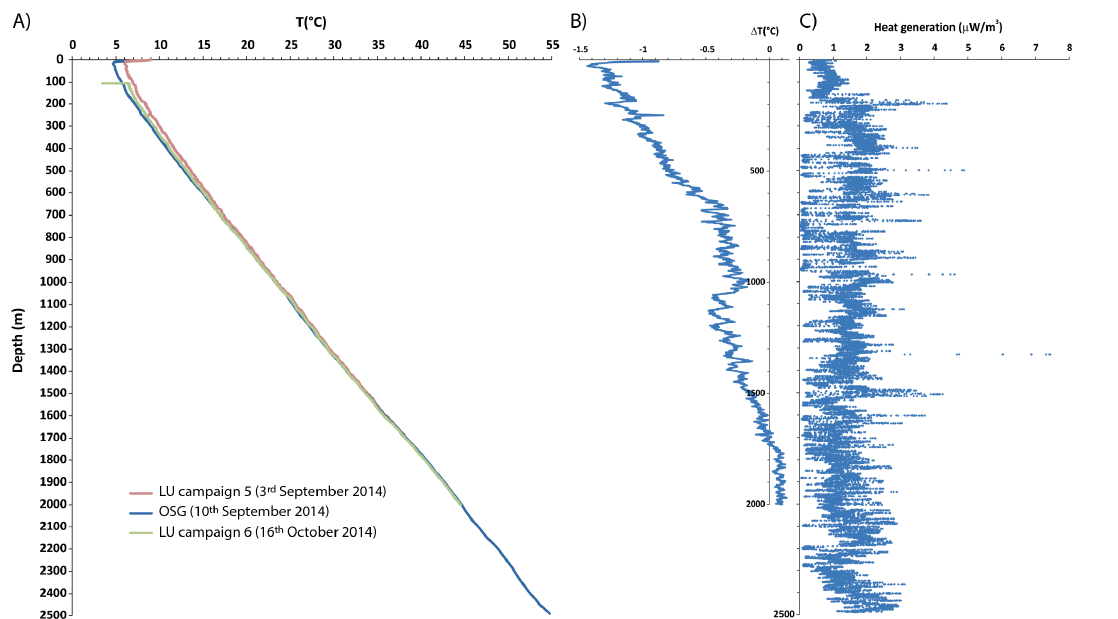
Figure 11. (a) Post-drilling temperature logs. Note gradual cooling (i.e. thermal re-equilibration) of the uppermost section of the borehole early in September 2014. The log measured in October is affected by post-drilling operations. (b) Temperature variations ( (cid:49)T ) in the COSC- 1 drill hole from 3 until 10 September 2014. (c) Heat generation rates as derived from the spectral gamma log measured in the COSC-1 drill